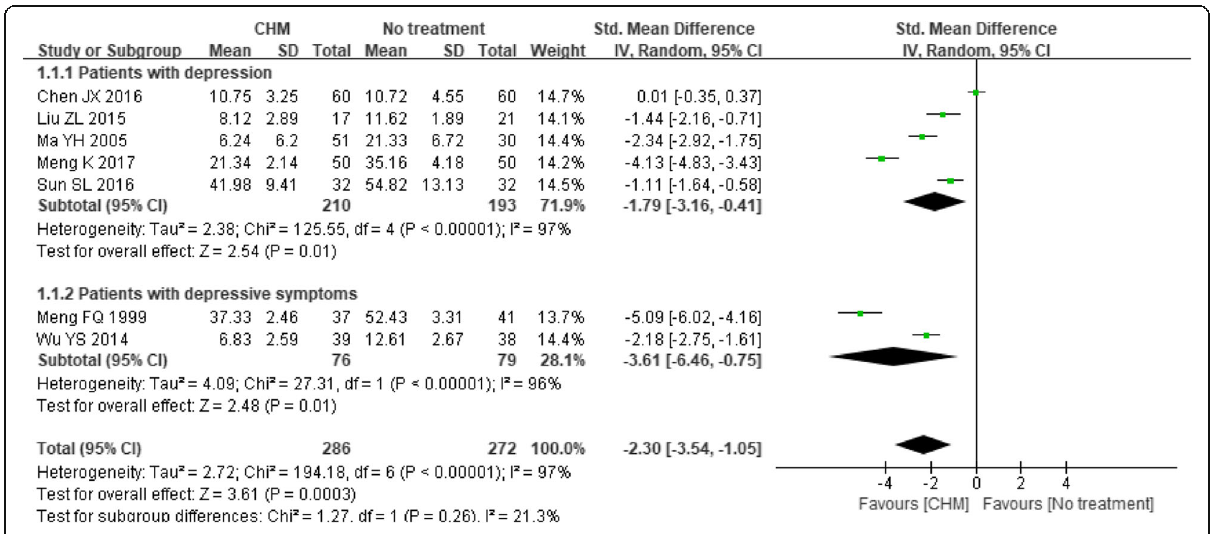
Fig. 3 Forest plot of mean depression scores for CHM versus no treatment